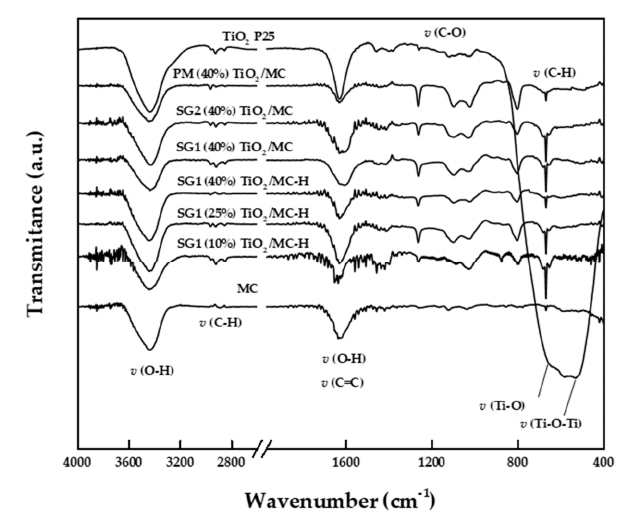
Figure 4. FT-IR spectra of the different catalyst in the 400–4000 cm − 1 range.